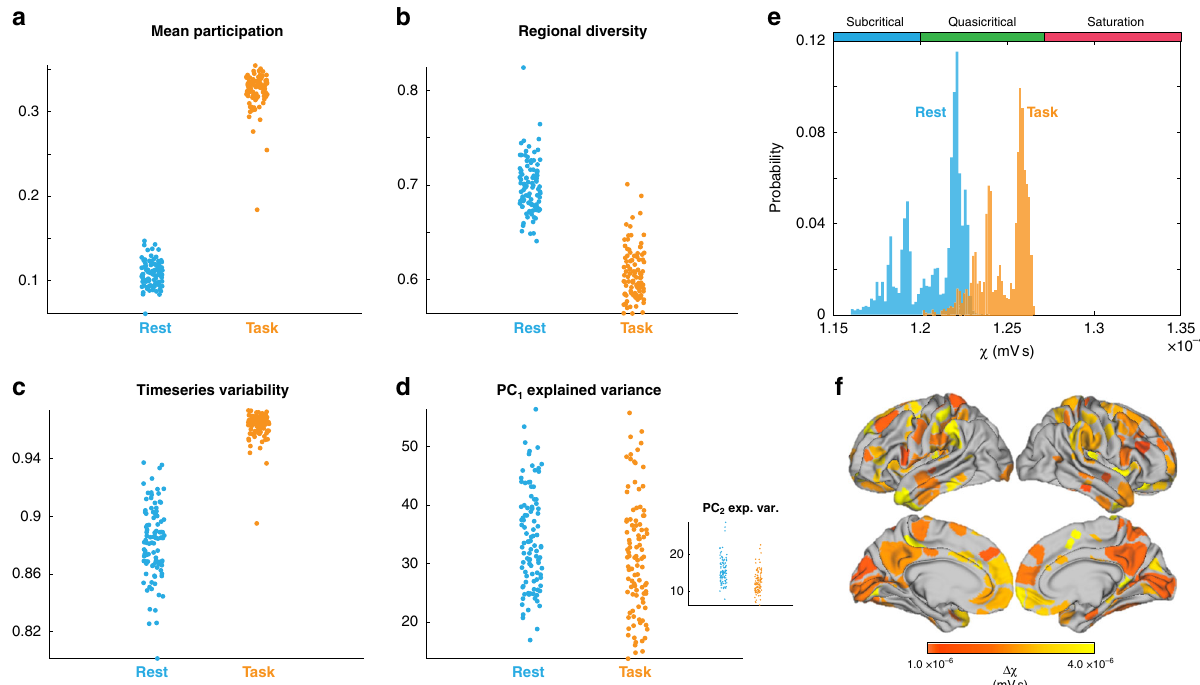
Fig. 5 Signatures of quasi-criticality across task and rest. fMRI data from 100 unrelated subjects during a two-back task from the Human Connectome Project were analyzed to determine whether the task and rest states were associated with unique signatures of complex, adaptive brain dynamics. a Mean Participation was elevated during task performance (paired t test: t = 83.8; p = 1.02 × 10 − 93 ). b Regional diversity, de fi ned as the variance in the upper triangle of the region-wise functional connectivity matrix, was lower during task performance than rest (paired t test: t = 29.1; p = 2.37 × 10 − 50 ); c fMRI time-series variability (paired t test: t = − 31.1; p = 6.83 × 10 − 53 ). d Variance explained by fi rst principal component (paired t test: t = 5.21; p = 1.04× 10 − 6 ). d (inset) Variance explained by second principal component (paired t test: t = 9.06; p = 1.23 × 10 − 14 ). e Task and rest signatures were applied to a novel stochastic data- fi tting algorithm to orient the brain states at different levels of χ : rest was associated with a lower diffuse coupling ( χ test ~ 1.22 ± 0.1 mV s) than task states ( χ task ~ 1.26 ± 0.1 mV s); ( f ) surface projection of Δ χ for each region 73 , generated by independently removing each region of the data, recalculating the signatures, and re fi tting to generate a Δ χ